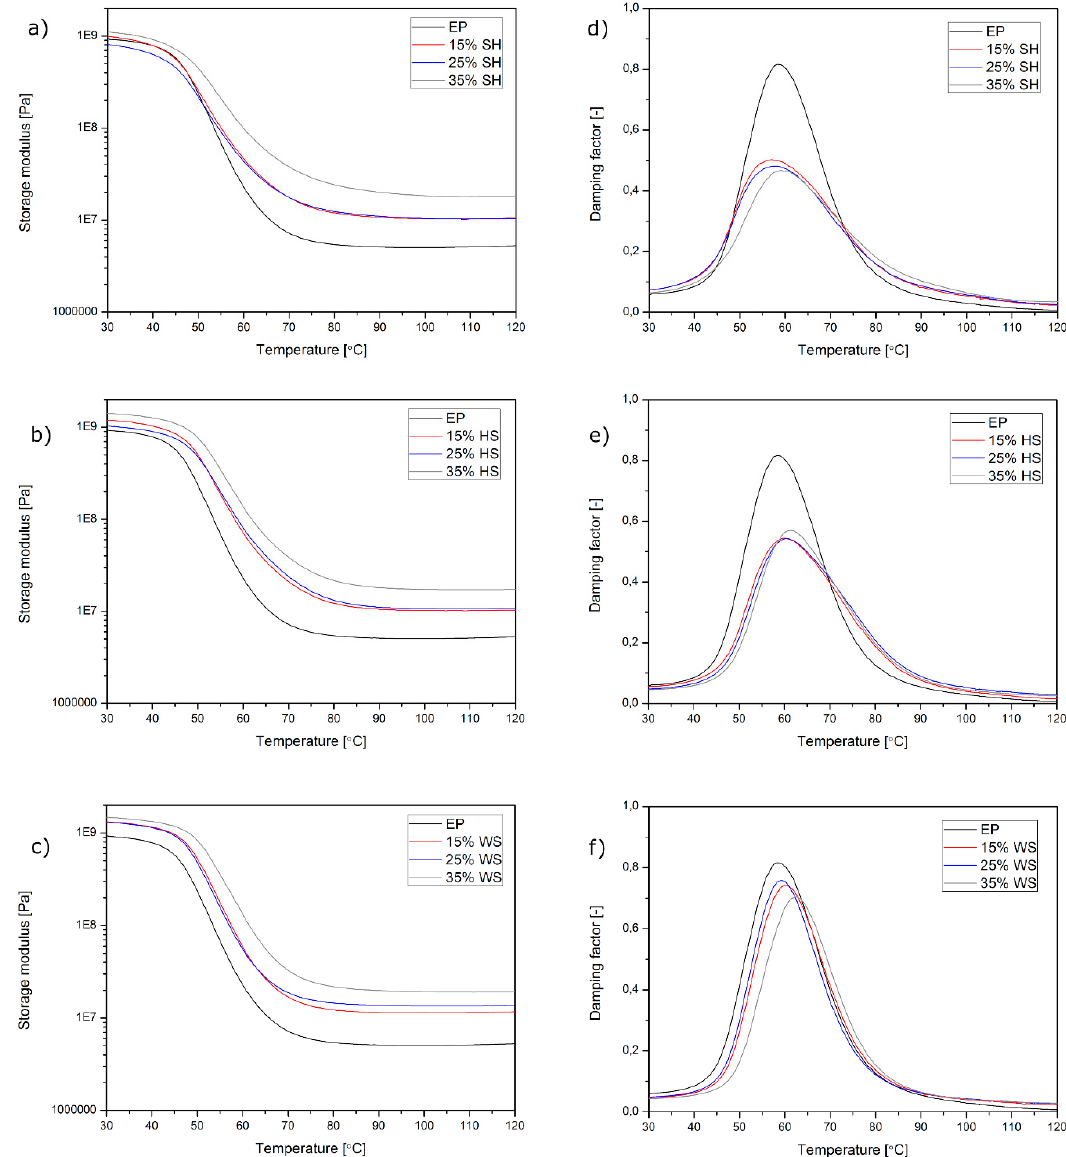
Figure 5. Storage modulus (G’) ( a – c ) and damping factor (tan δ ) ( d – f ) as a function of temperature of pure cast epoxy sample and epoxy-based composites.